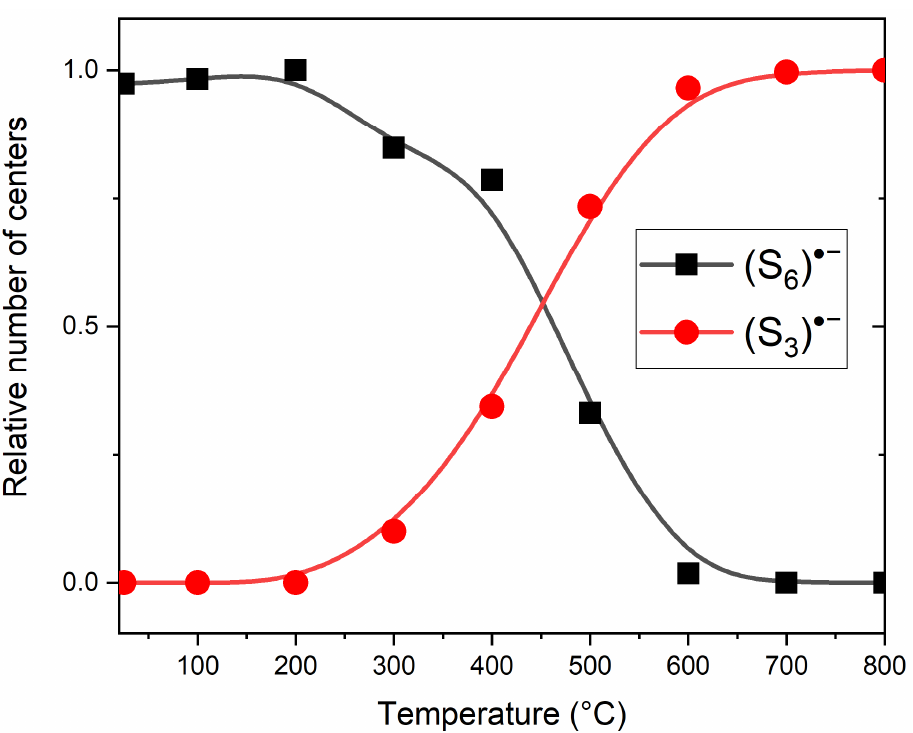
Figure 16. Relative amounts of polysulfide radical anions in haüyne (Sample 3) heated at different temperatures. The values of the relative amounts are normalized to the maximum number of each of the radical anions.